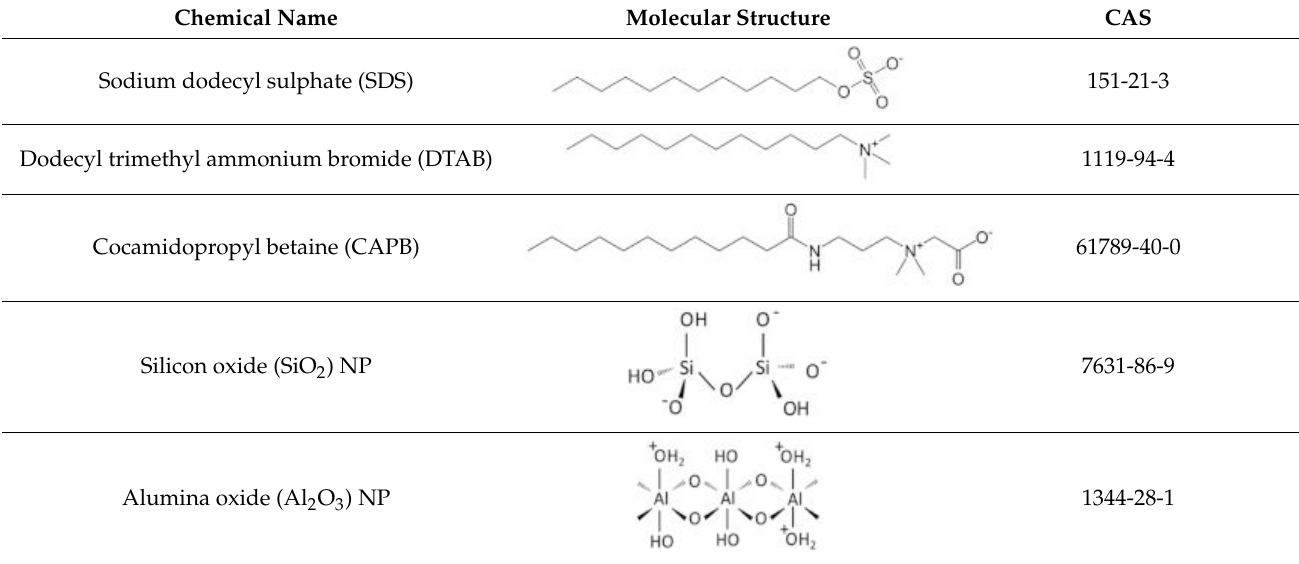
Table 1. Chemical names and structures of the surfactants and nanoparticles used in this work.